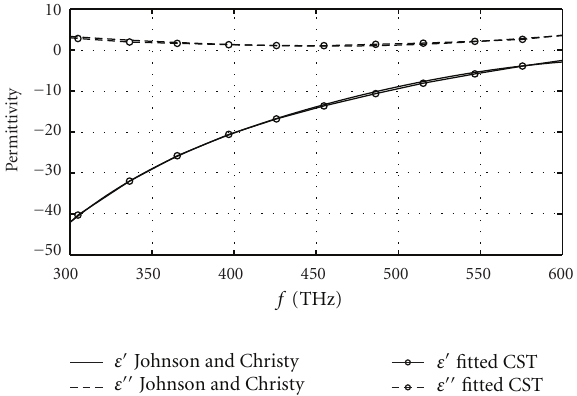
Figure 3: Complex permittivity of gold used in EM simulations (CST Microwave O ffi ce). Values are based on measured data from [14] and fitted using fourth-order polynomial.